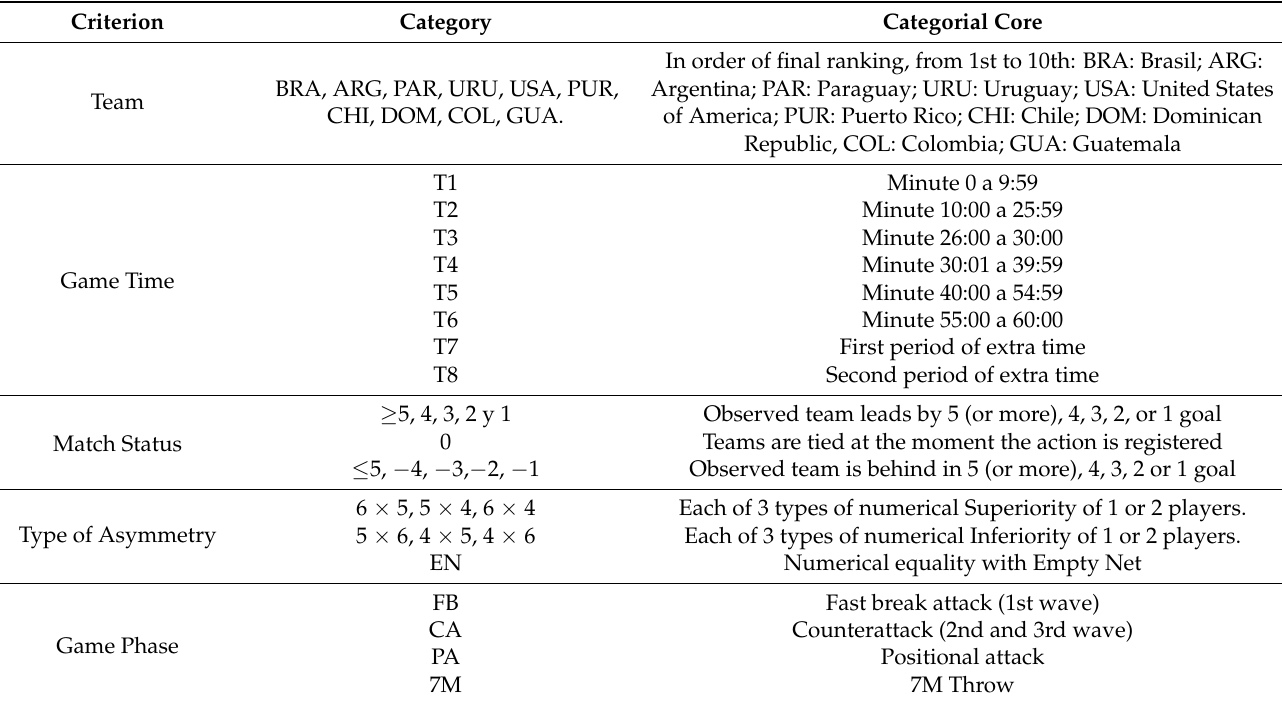
Table 1. Observational